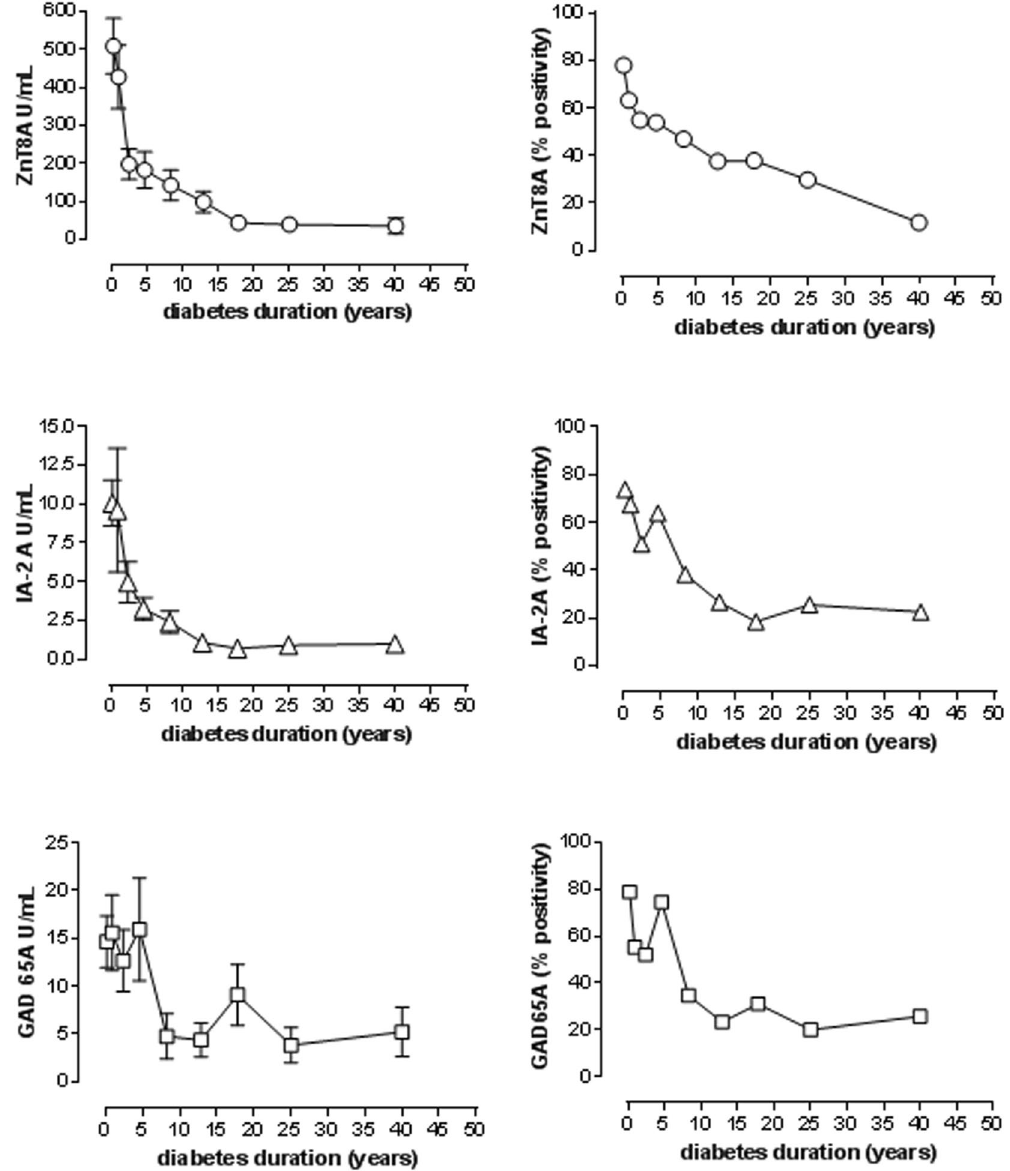
Figure 1. Mean levels (U/mL) and frequencies of autoantibodies against zinc transporter-8 (ZnT8A), glutamic acid decarboxylase (GAD65A) and tyrosine phosphatase (IA-2A) according to diabetes duration